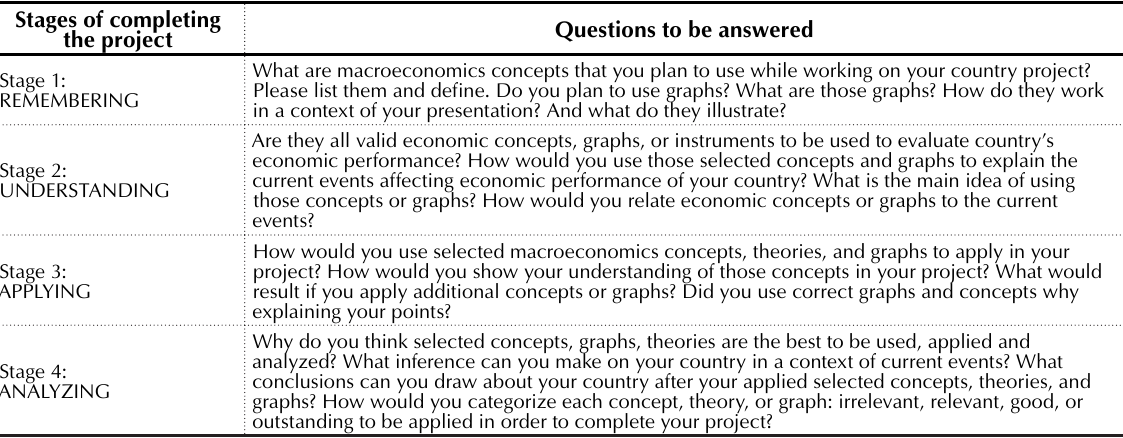
Source: Principles of Macroeconomics, U.S. Coast Guard